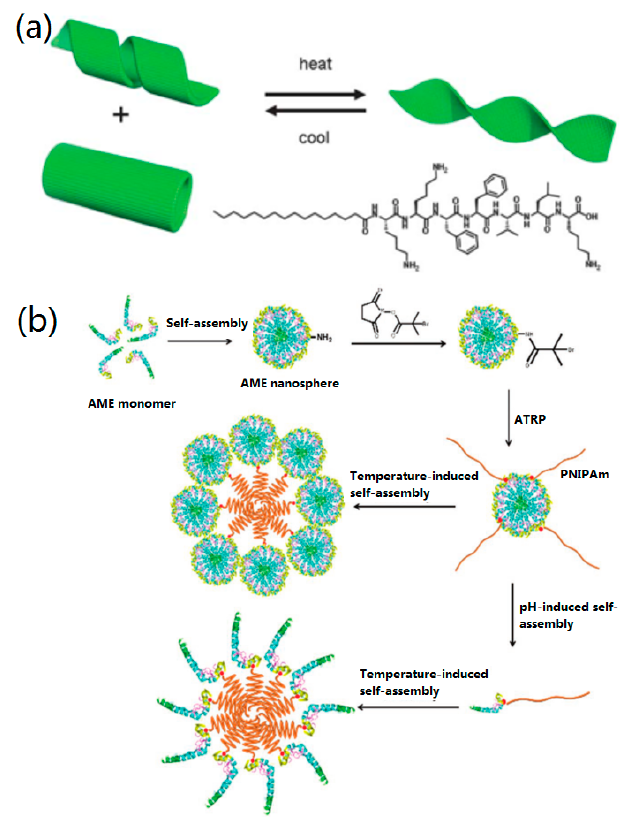
Figure 8. The temperature effect on biomolecular self-assembly: ( a ) The thermo-reversible transition and (bottom right) structure of PA. Reprinted with permission from [125]. Copyright 2013 The Royal Society of Chemistry. ( b ) The synthesis and proposed model of self-assembly and disassembly of pH- and temperature-responsive Amelogenin (AME)–PNIPAm bioconjugates. Reprinted with permission from [126]. Copyright 2018 WILEY-VCH.